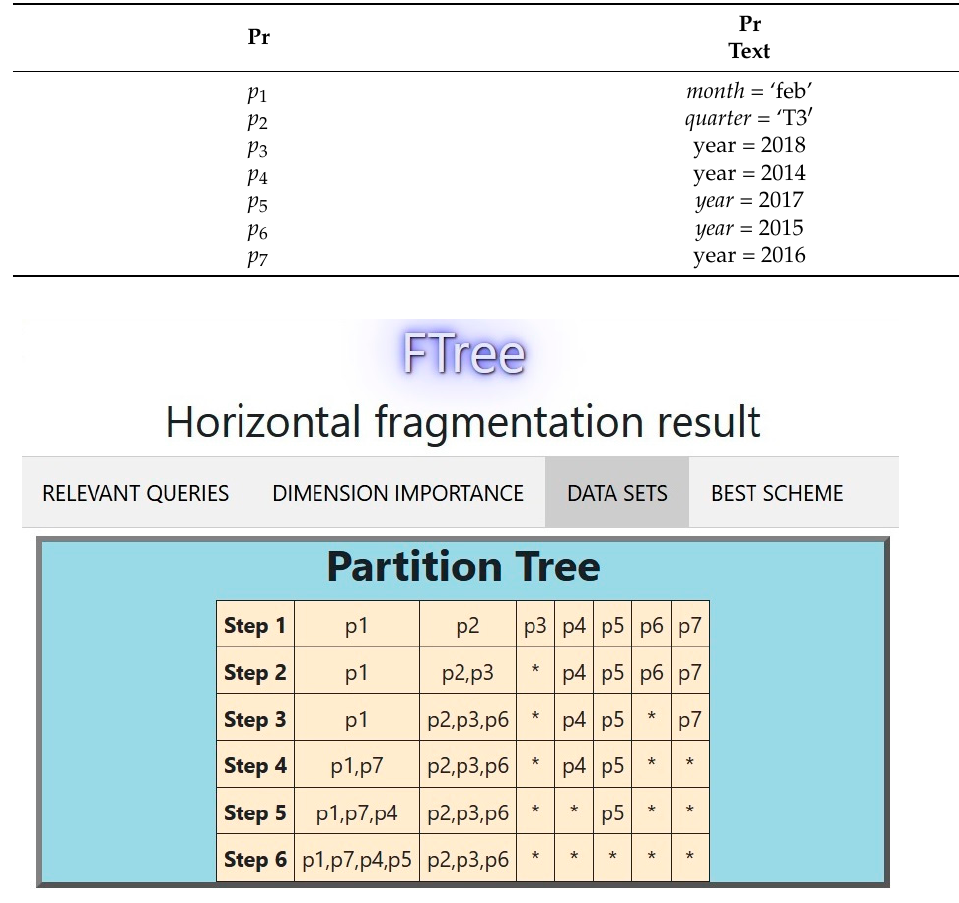
Table 11. Predicates for the first experiment.